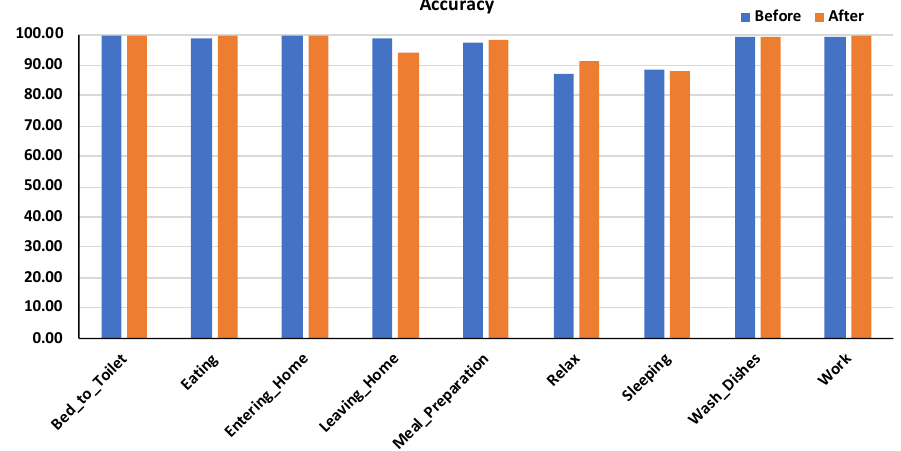
Figure 12. Comparison of accuracy values of paradigm #3 before and after applying semantic preprocessing.